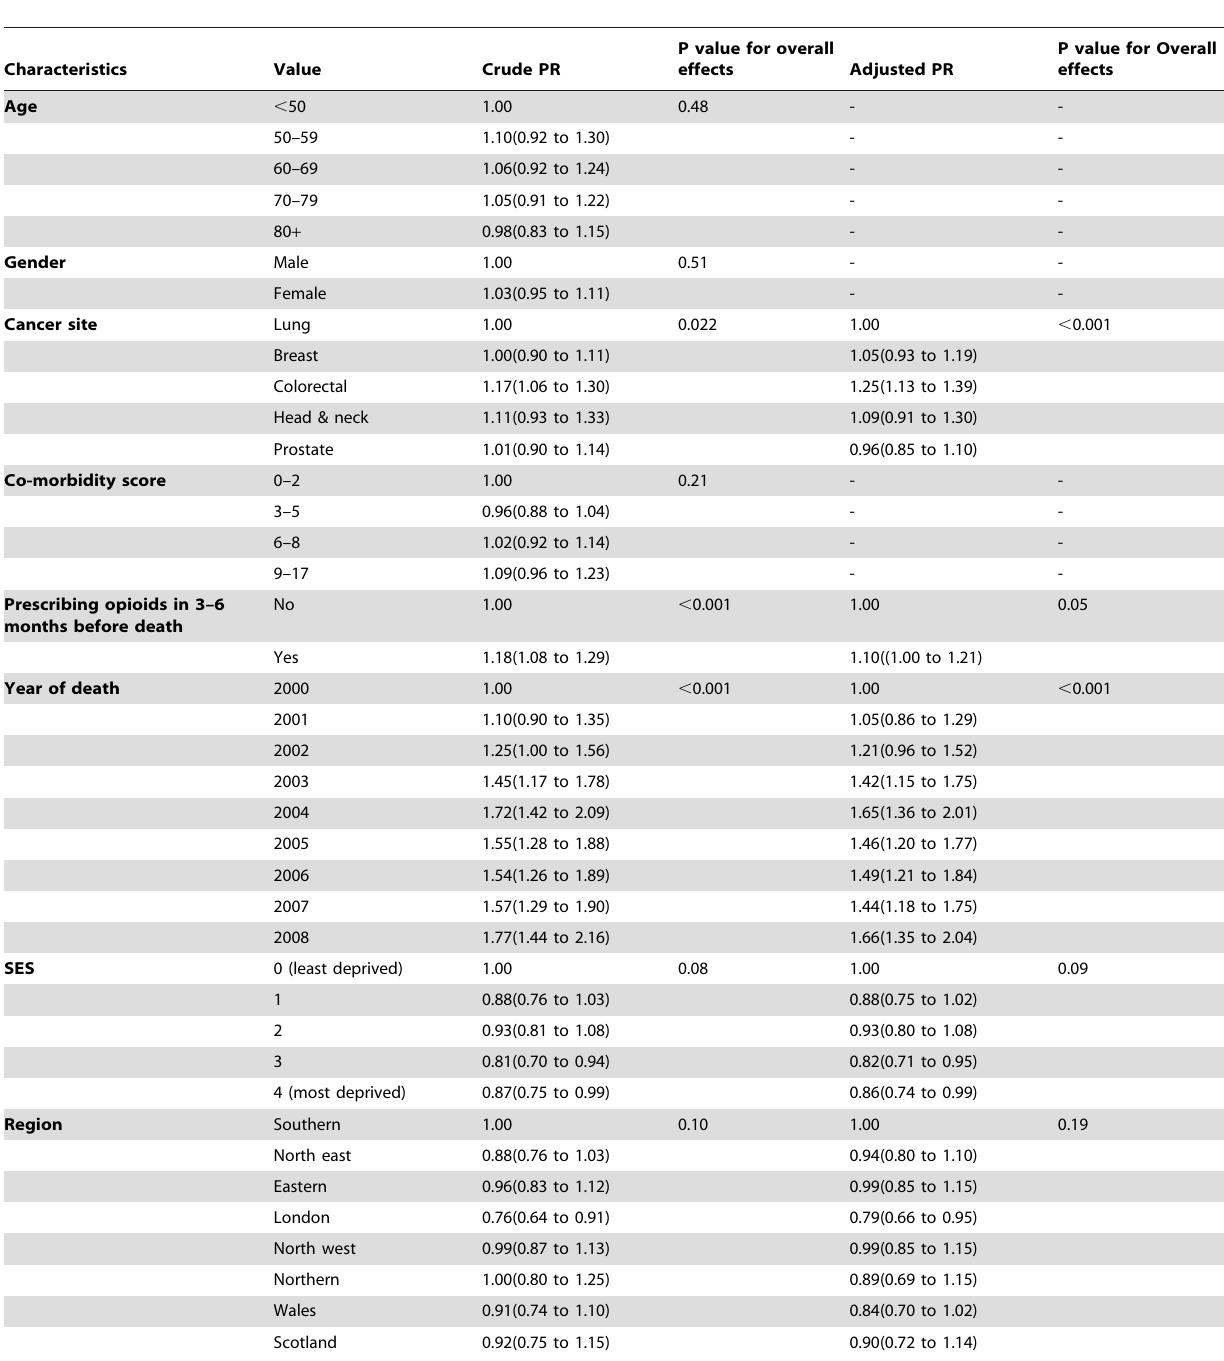
Table 2. Crude prevalence ratios (CPR, 95%CI) and adjusted prevalence ratios (APR, 95%CI)* of factors associated with the number of type of strong analgesics a patient received in the last three months of life (N =13,427).